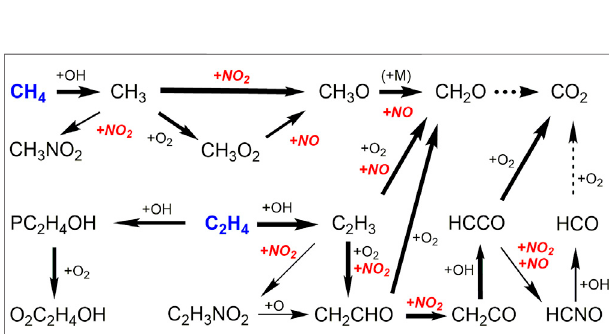
FIGURE 6 | Major reaction paths of CH 4 and C 2 H 4 in the oxidation of GM1, GM2, GM5 and GM6 at 1239, 886, 1239, and 886 K, respectively.